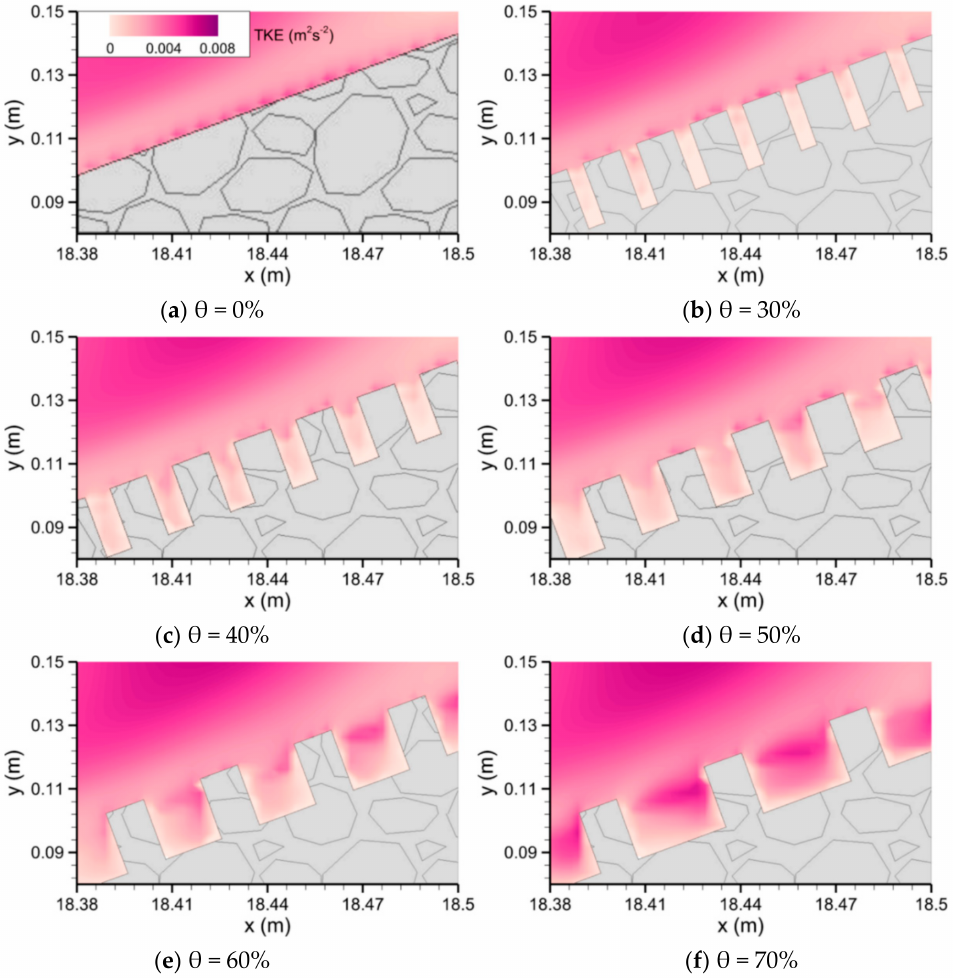
Figure 13. Turbulent kinetic energy distribution near cavities of fence plate from x = 18.38 m to 18.5 m for different gap ratios ( a – f